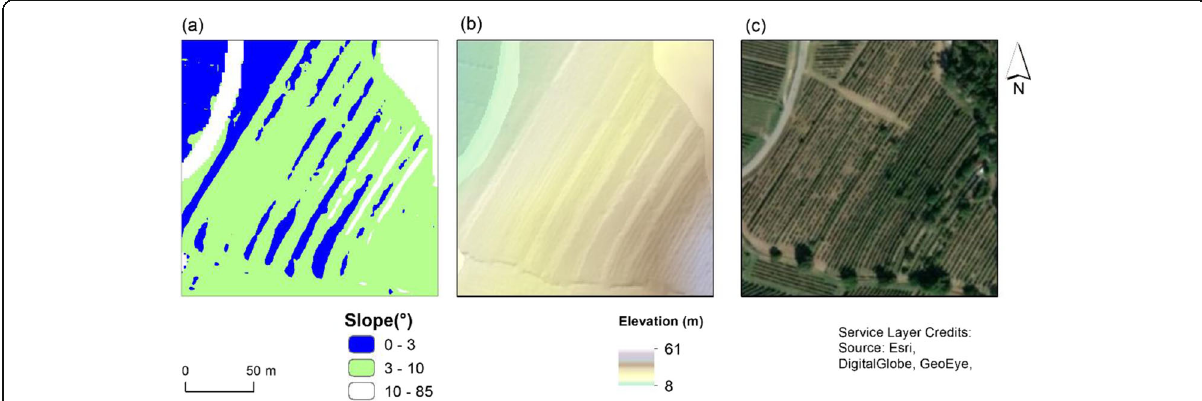
Fig. 9 Overview of a typical vineyard in the plain to hilly landscape (from ( a ), the blue color represents the first slope peak value which is the terrace bench, and the green shows the second slope peak value which represents the terrace walls; ( b ) and ( c ) presents the corresponding elevation and satellite image)